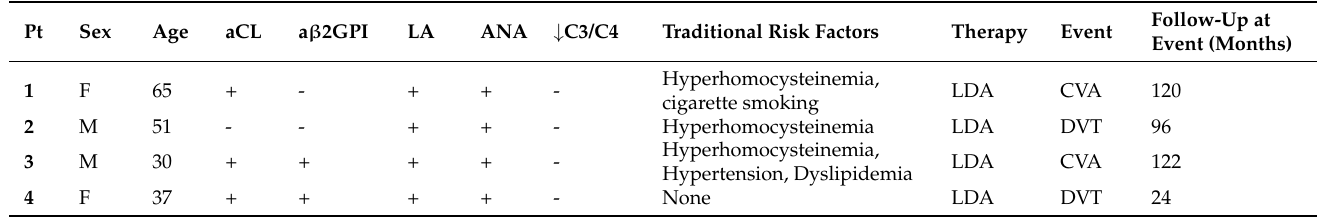
Table 1. Main demographic, laboratory and clinical features of four aPL carriers developing throm- botic events.